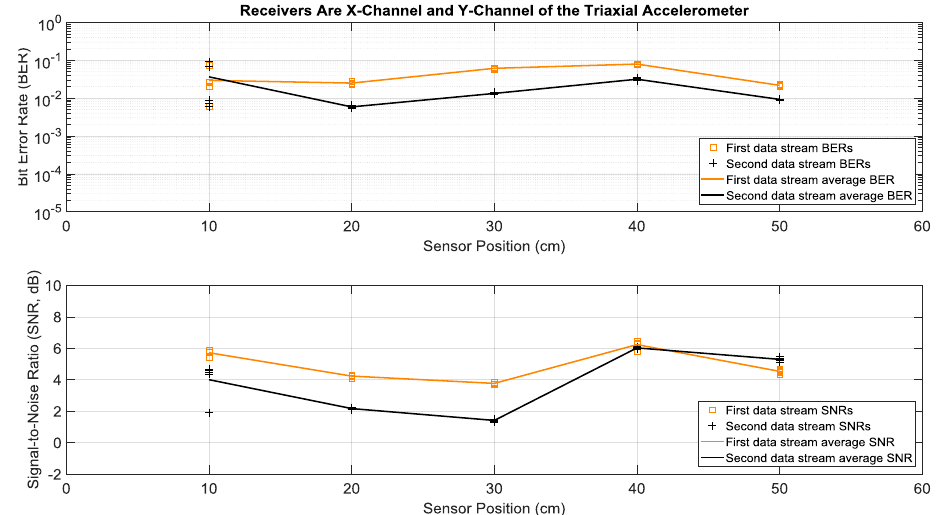
Figure 9. BERs ( top ) and SNRs ( bottom ) at different receiver positions, with two actuators transmitting two data streams simultaneously. The receivers were the x -channel and y -channel of a triaxial accelerometer. The piecewise linear graphs represent average BERs and SNRs for each of the two data streams versus the receiver position.